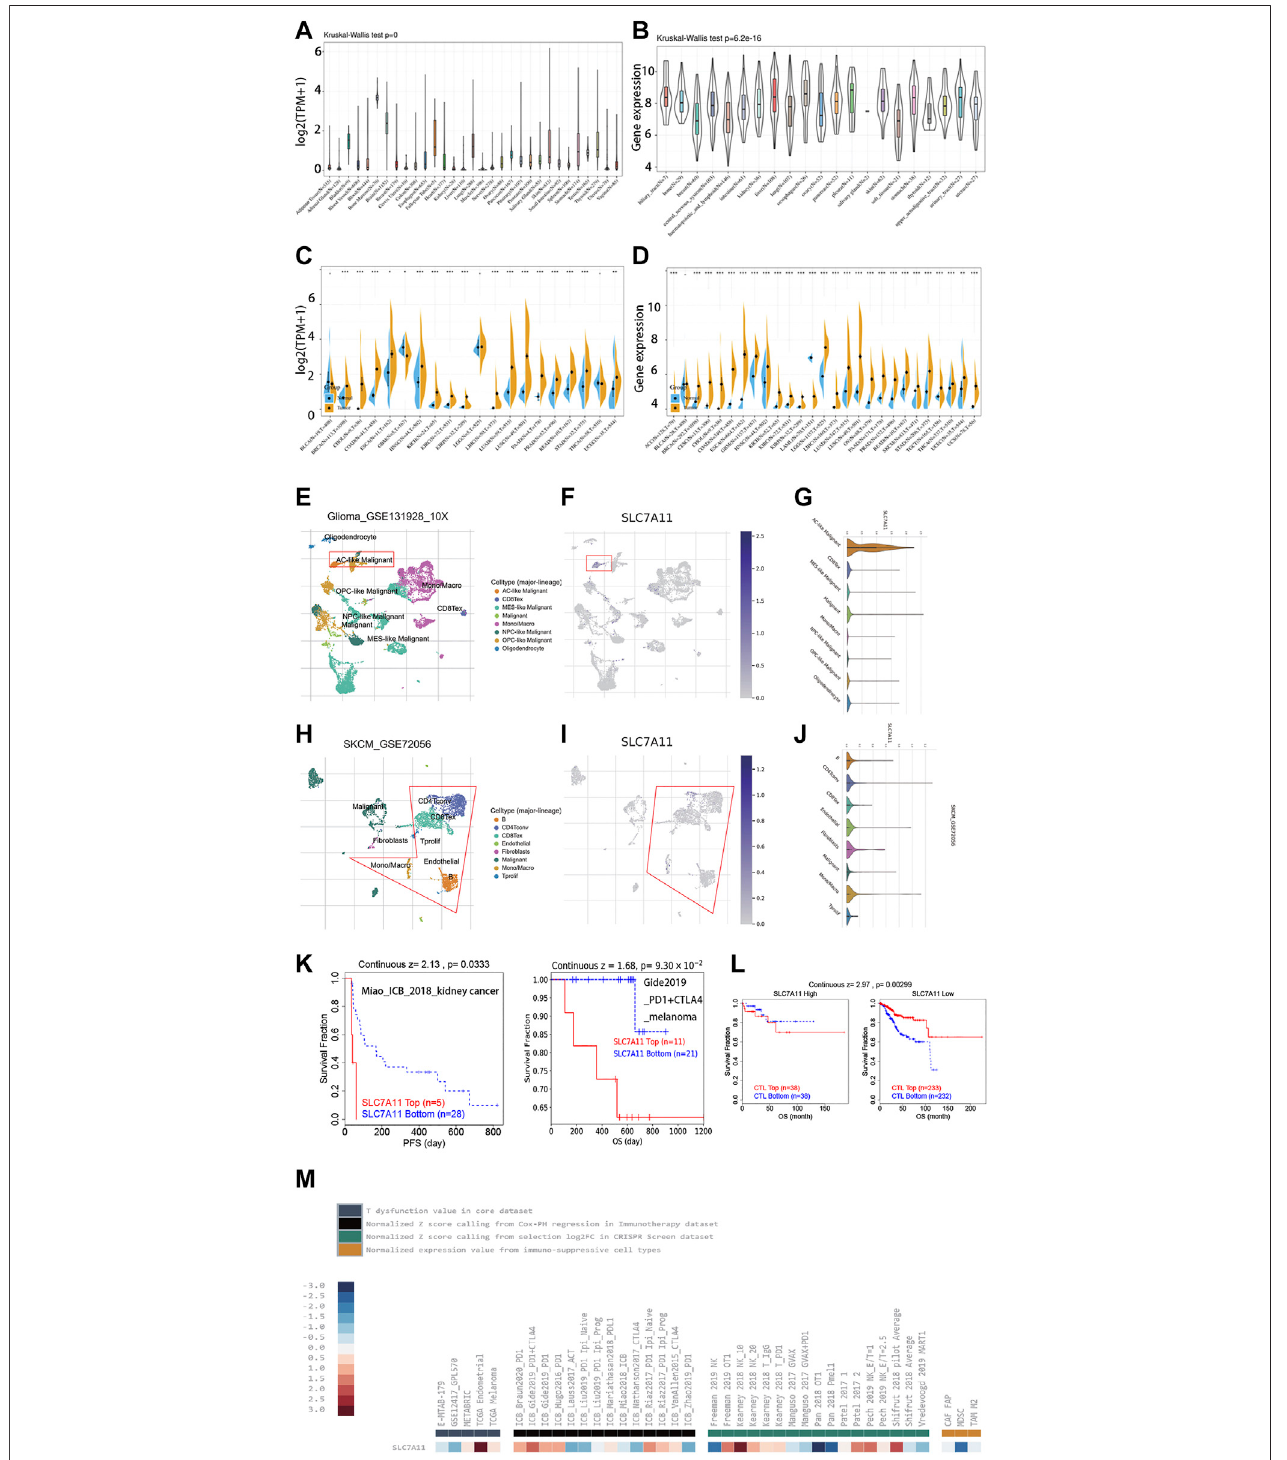
FIGURE1| ThedifferentialexpressionofSLC7A11indistinctcancers. (A) TheexpressionlevelofSLC7A11in33normalorgans. (B) TheexpressionlevelofSLC7A11 in 21 cancer cell lines. (C) Investigation of the differential expression of SLC7A11 between cancers and normal tissues using TCGA data. (D) Investigation of the differential expression of SLC7A11 between cancers and normal tissues using the data from TCGA combined with GTEx. (E – J) Single-cell analysis and TIDE algorithms revealing the expression distribution and immunosuppressive characteristic ofSLC7A11 in cellclusters. (K) Immunotherapy prolonged the survival expectancy onlyin patients with lower SLC7A11 expression. (L) SLC7A11 is associated with increased CTL cytotoxicity based on TIDE algorithm; CTL top referred to samples with higher CTL in fi ltration,